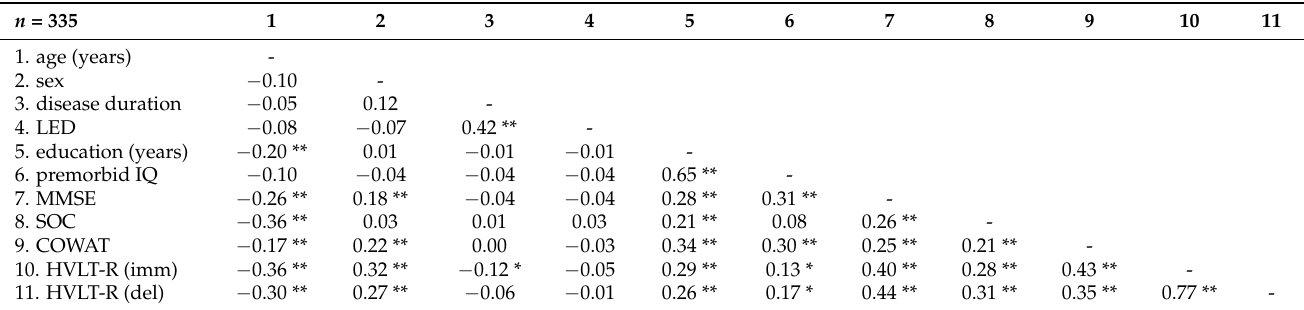
Table 2. Correlation matrix (r) of demographic characteristics and outcome